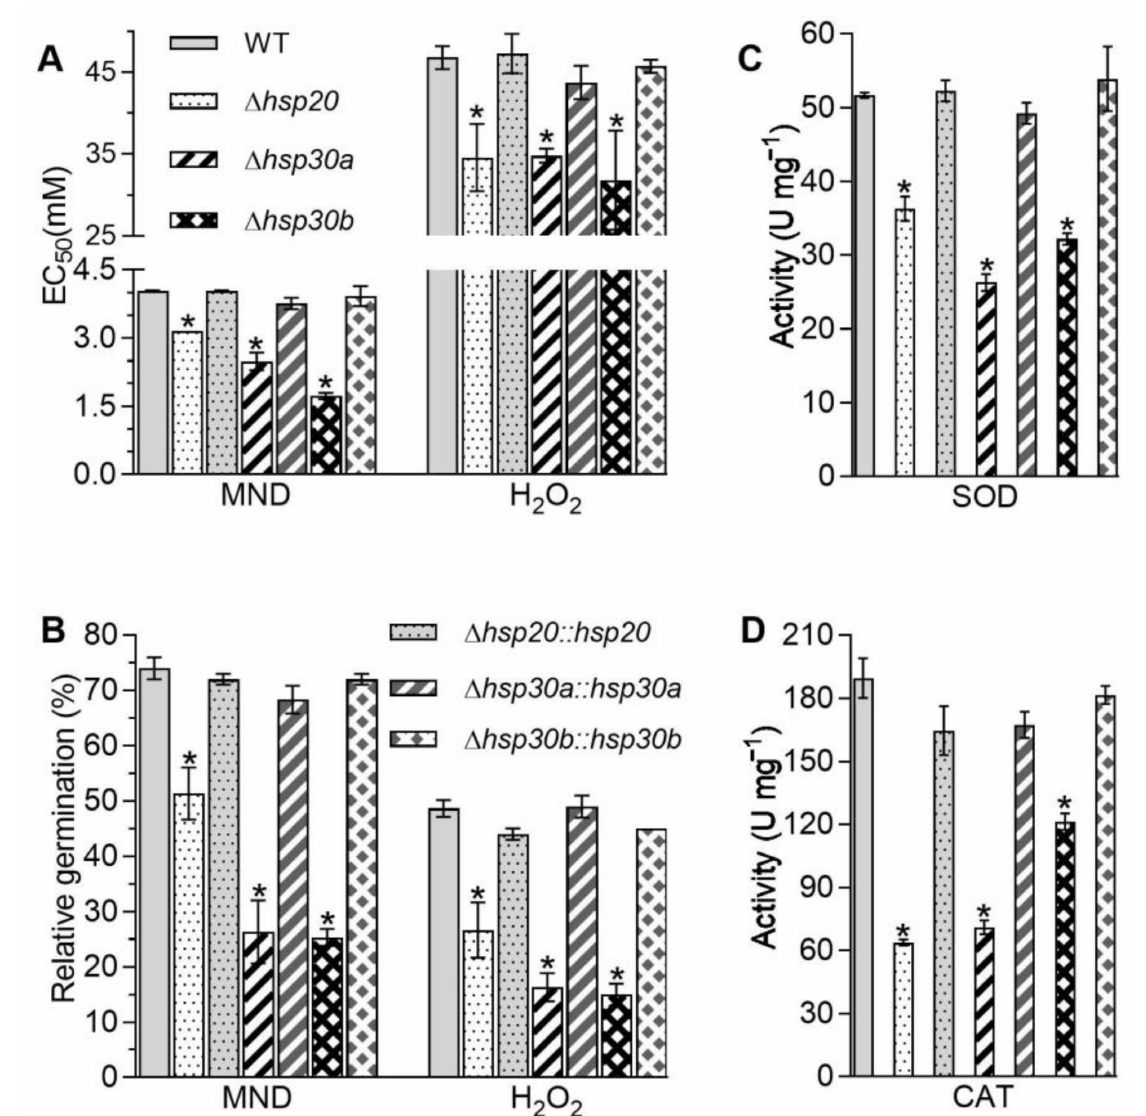
Figure 4. Essential roles of hsp20 , hsp30a , and hsp30b in cell response to oxidative stress. ( A ) EC 50 s for menadione (MND) and H 2 O 2 to suppress 50% colony growth of each strain after 6 d incubation at 25 ◦ C on 1/4 SDAY plates. ( B ) Relative germination percentages of conidia on the GM plate alone and supplemented with MND (0.2 mM) and H 2 O 2 (4 mM) after 24 h incubation at 25 ◦ C. ( C , D ) Total SOD and CAT activities quantified in the protein extracts from 3-day SDAY cultures. Asterisked bars in each bar group differ significantly from those unmarked (Tukey’s HSD, p < 0.05). Error bar: SD from three